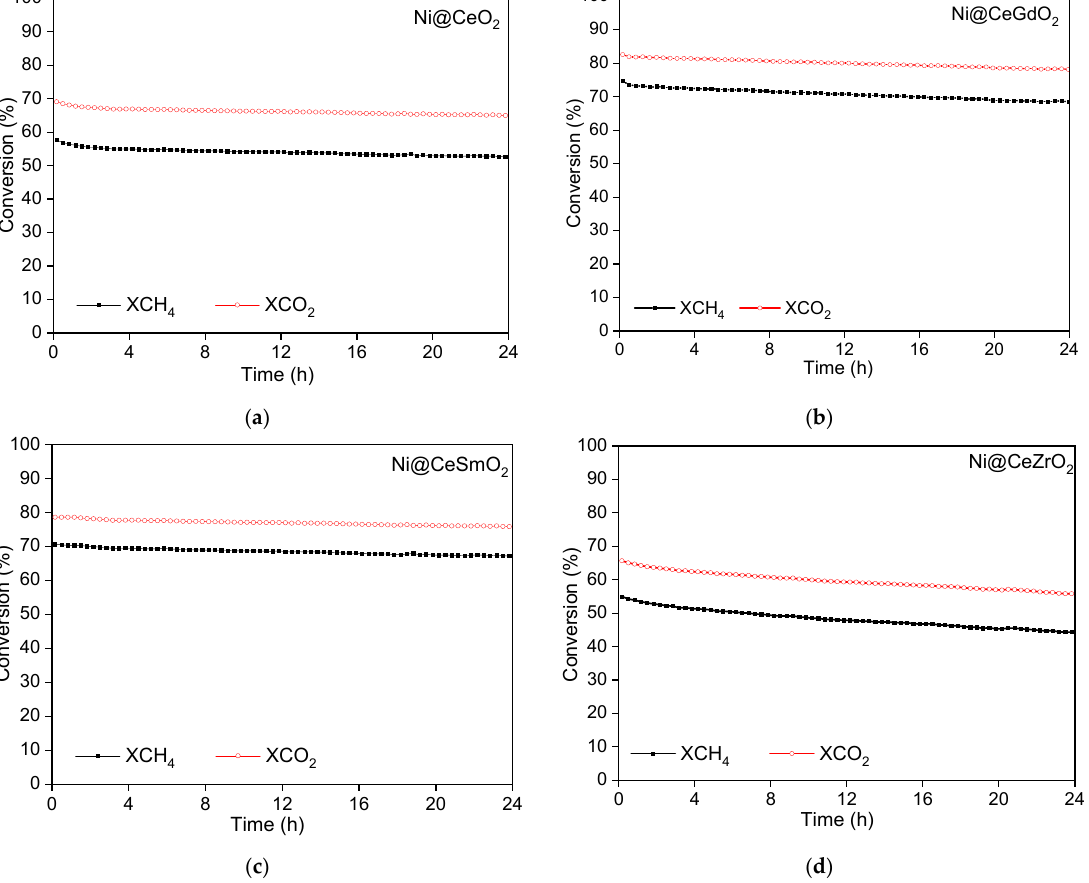
Figure 9. H 2 /CO molar ratio obtained in the the DRM at 800 °C as a function of TOS (CH 4 /CO 2 molar ratio of 1.0; W/F = 0.2 g cat .L − 1 h − 1 ).